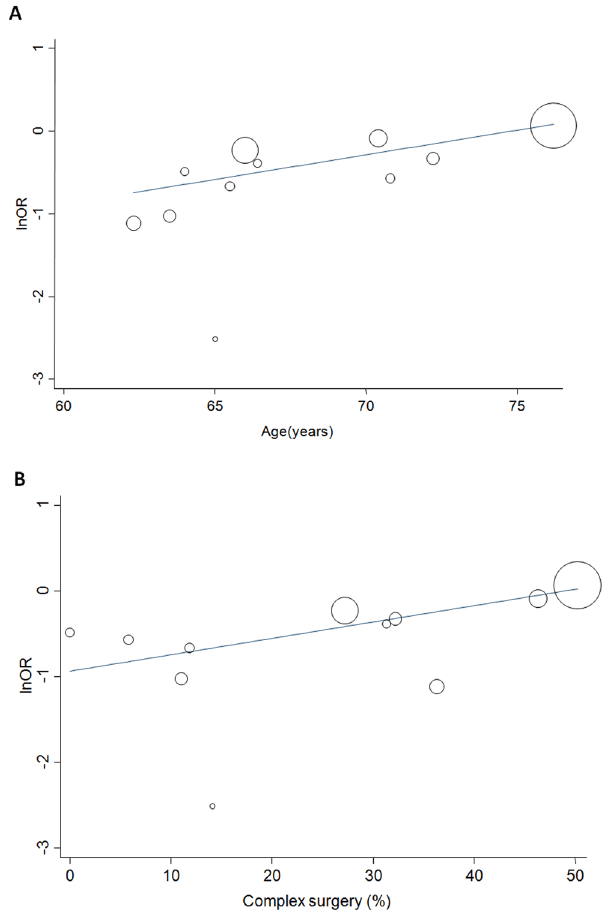
Figure 4. Meta-regression plots on the incidence of AKI stage I against ( A ) age and ( B ) proportion of complex